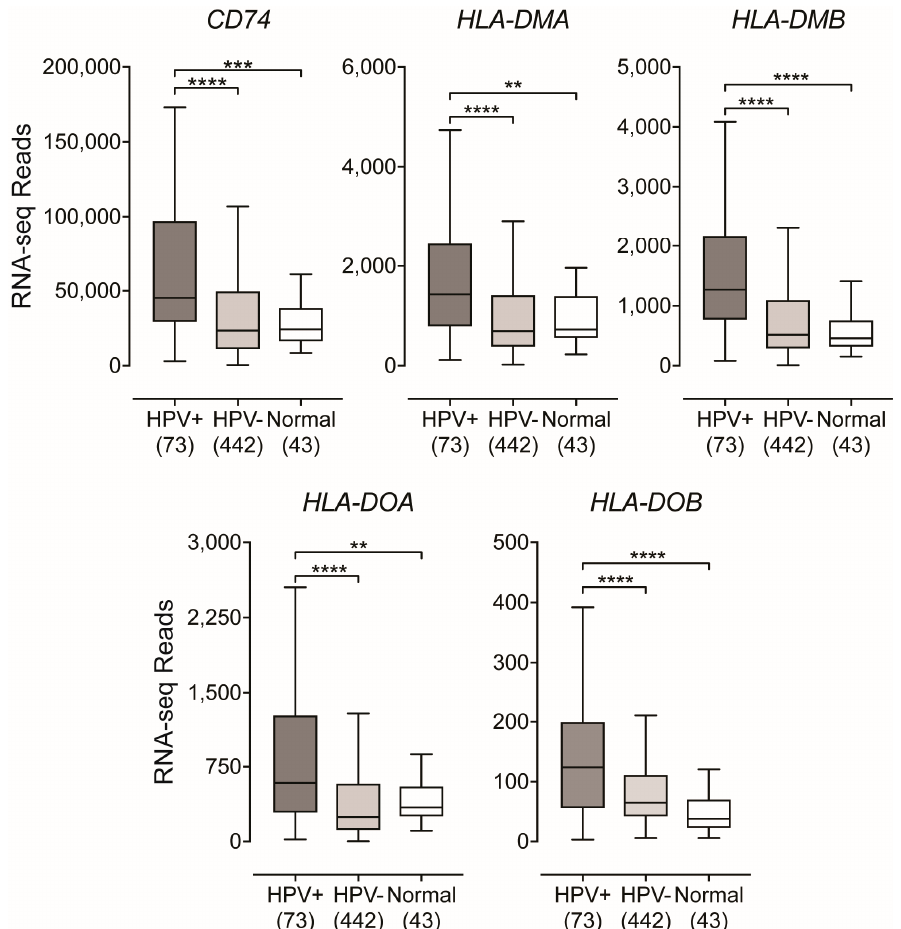
Figure 2. Expression of the invariant chain and MHC class II-like genes in head and neck carcinomas stratified by HPV-status. RSEM normalized RNA-seq data for the indicated genes involved in MHC-II-dependent antigen processing and presentation was extracted from the TCGA database for the HNSC cohort for HPV + , HPV − , and normal control tissues. Numbers in brackets refer to the number of samples included in each analysis. Statistical analysis was performed using a two-tailed non-parametric Mann–Whitney U test. ** p ≤ 0.01, *** p ≤ 0.001, **** p ≤ 0.0001, ns—not